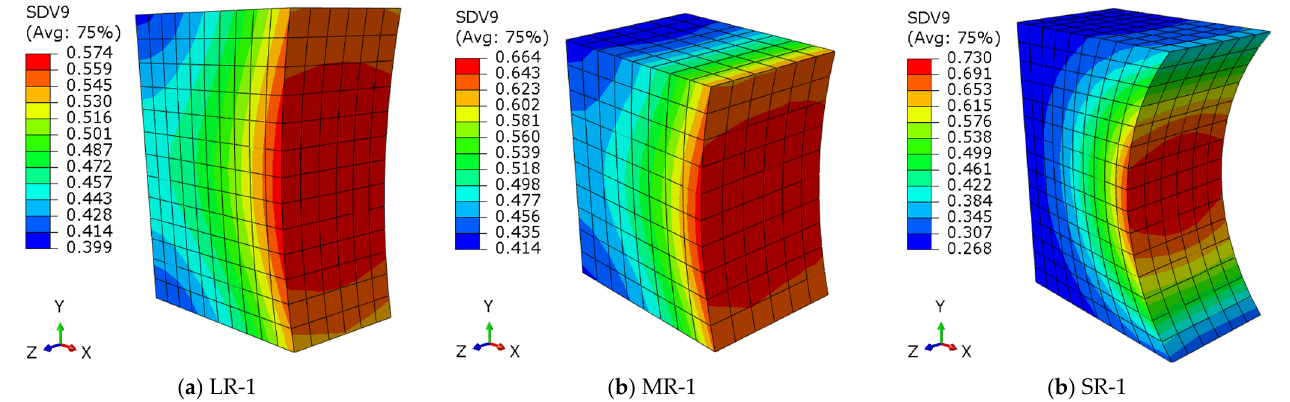
Figure 9. Damage contour plots at N = 40,000 (SDV9 = d f ).